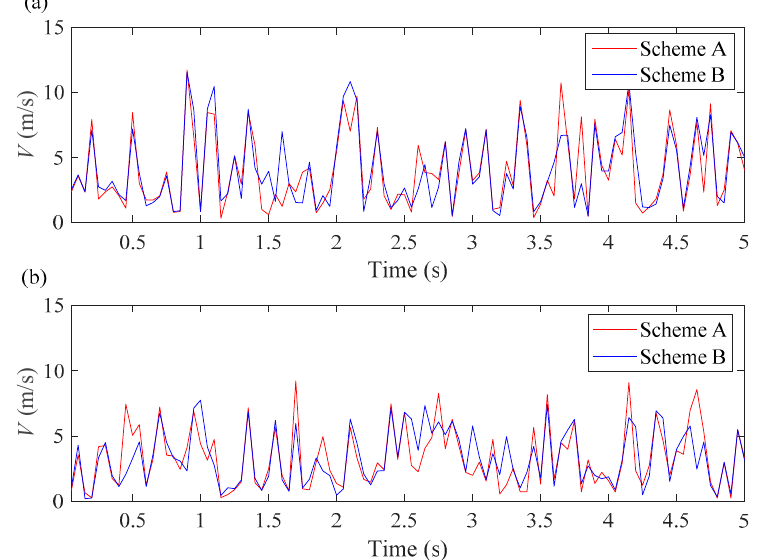
Figure 9. The magnitudes of the velocities estimated from Scheme A and Scheme B. ( a ) and ( b ) correspond to the two experimental conditions of Figures 7 and 8, respectively.